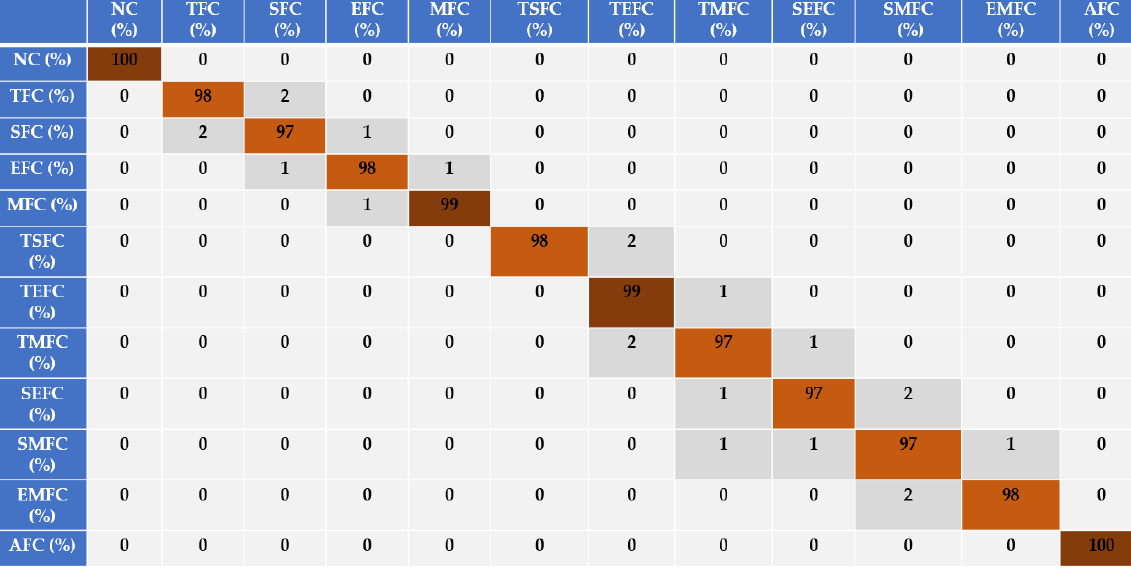
Figure 12. Sensor-fault-classification accuracy using the proposed FGAL-FLCR and an SVM.